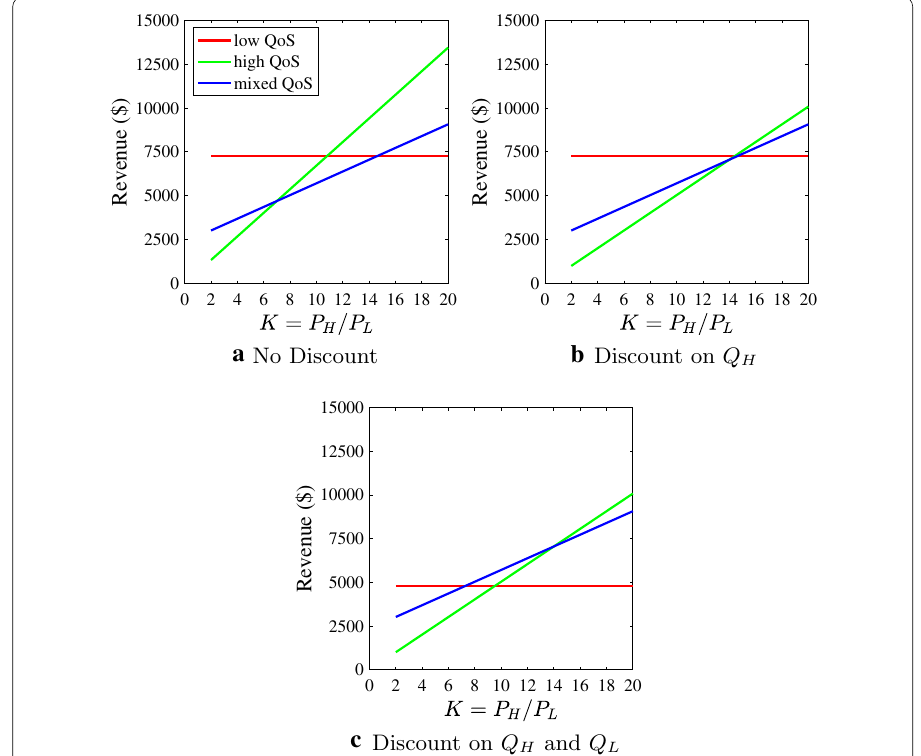
Fig. 2 Revenue for the three QoS scenarios for the cases with (i) no discount, (ii) 50% discount for N H − N H , M high QoS users, (iii) discount as in (ii) along with 20% discount for N L − N L , M low QoS users. Technical parameters: f = 800 MHz, indoor. The choice of the QoS class is